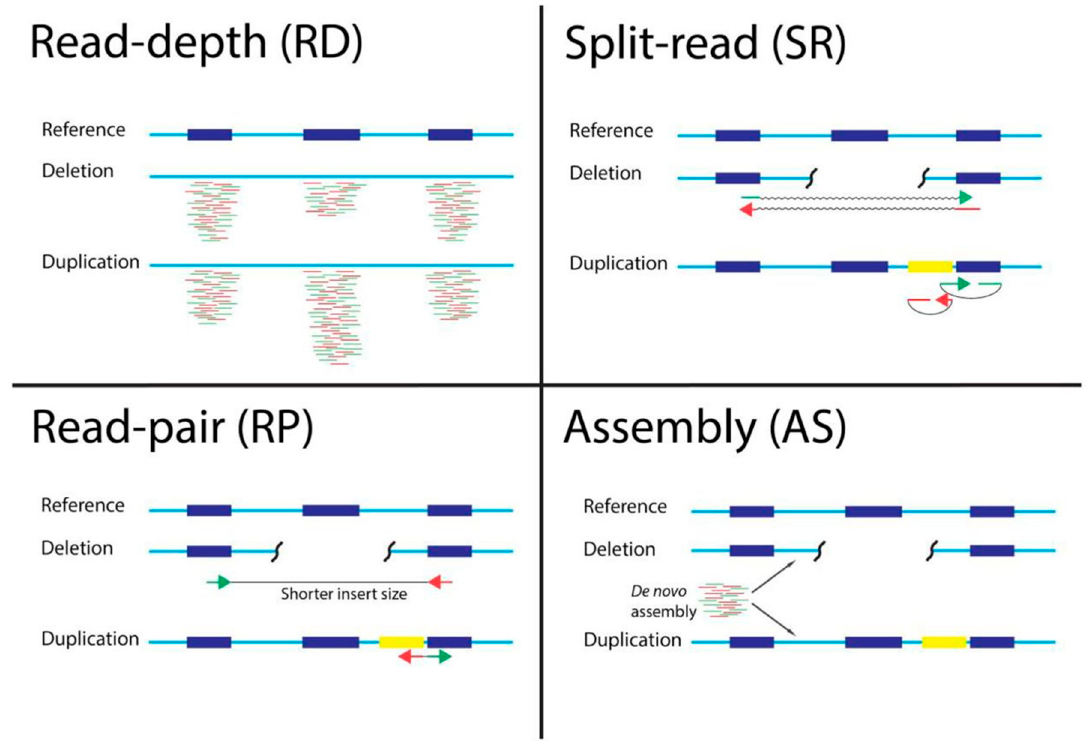
Figure 1. Schematic visualization of different approaches for calling CNVs from NGS data. RD detects local difference in read-depth, SR detects unmatched read pairs, RP detects decreased insert size or swapped read directions between read pairs, and AS performs de novo assembly to best explain read distribution.